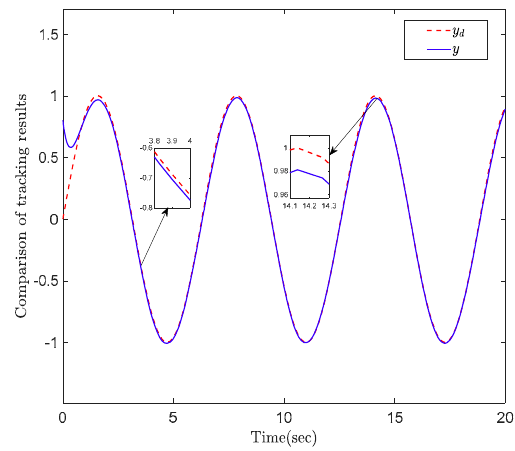
Figure 1. Output y and y d